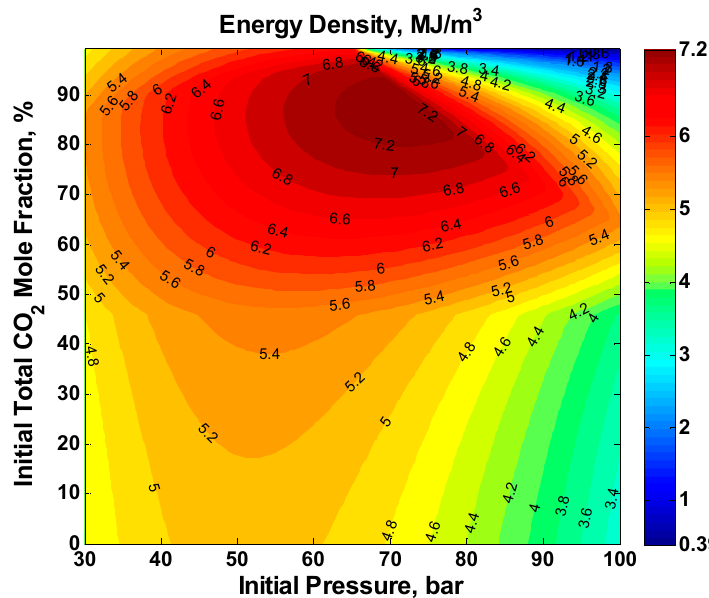
Figure 6. Contour plot of energy density (ED) vs. initial total pressure and initial total CO 2 mole fraction.